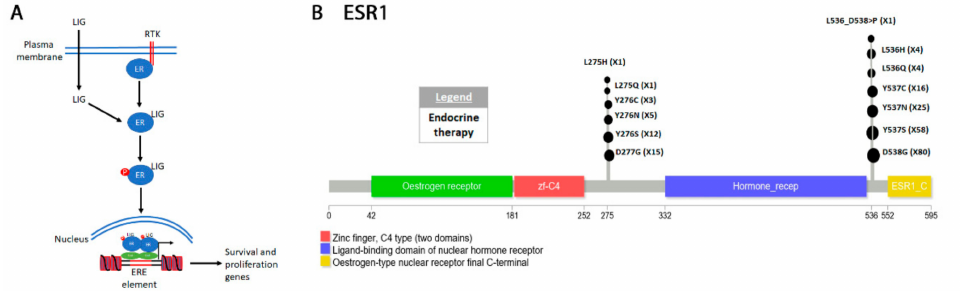
Figure 5. ERalpha (ESR1) in breast cancer. ( A ) Upon binding to its ligand the estrogen receptor translocates to the nucleus where it interacts with estrogen response elements to activate survival and proliferation genes. Estrogen receptor (ER) phosphorylation also appears to be required for activation. Not discussed here are the roles of the ER receptor in activating cytoplasmic signal transduction pathways through interaction with plasma membrane receptors [496]. ( B ) Resistant mutations in ESR1 arising in response to endocrine